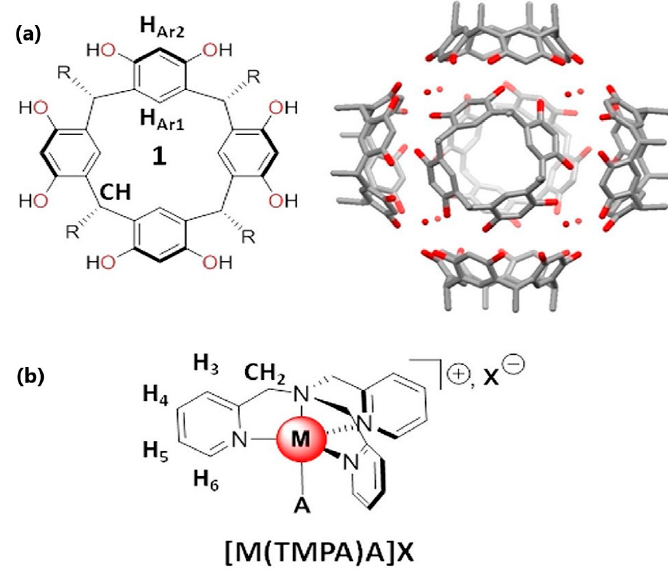
Figure 3. Encapsulation of a metallocomplex ( b ) in capsule ( a ). ( a ) The resorcin[4]arene 1 (R=C 11 H 23 ) and structure of the H-bonded capsule. Reprinted with permission from (Zhang et al., 2021) [20]. Copyright 2021 Elsevier.